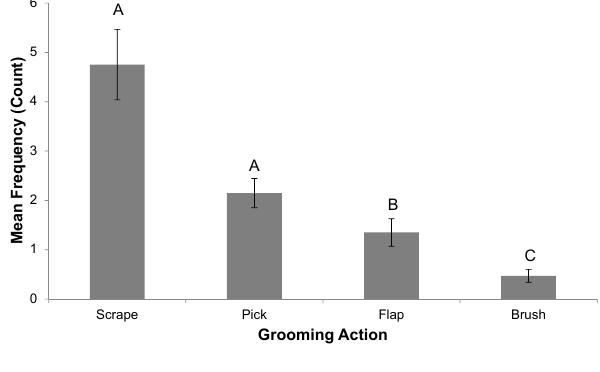
Figure 5. Mean frequency of grooming mechanism, with standard error bars, mechanisms in 30-min isolation observations (N=142; scrape/pick: z=1.16, p=0.246; flap/brush: z=2.18, p=0.029). Note: Similar letters indicate no statistical significance (p>0.05) and different letters indicate a statistical significance